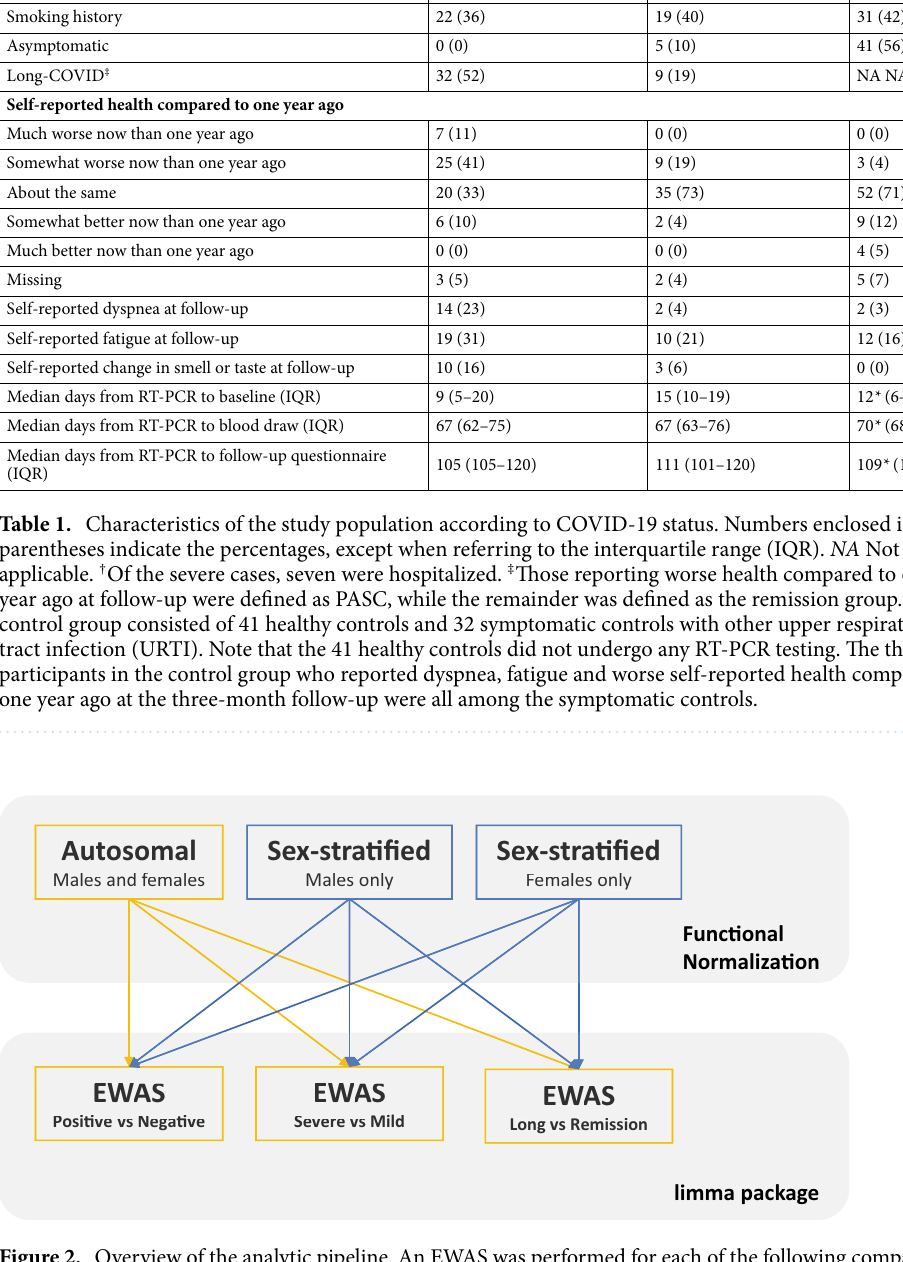
Figure 2. Overview of the analytic pipeline. An EWAS was performed for each of the following comparisons: (i) COVID-19 positive vs COVID-19 negative, (ii) severe COVID-19 vs mild COVID-19, and (iii) long- COVID vs the remission group (labeled ‘Remission’ in the figure). Additional comparisons are provided in Supplementary Figs. 8 and 9. We applied the R package limma 63 on functional normalized M-values in each EWAS. In total, we conducted nine separate